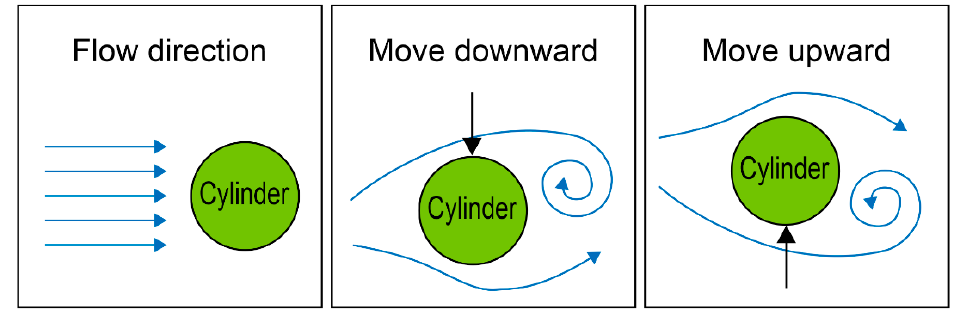
Figure 1. Schematic of the vortex-induced vibration of a cylinder.